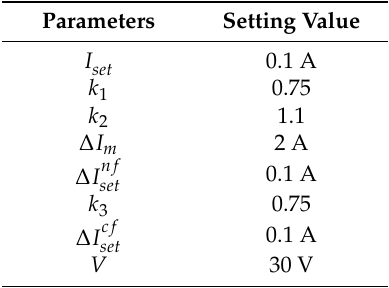
Table 4. Parameters of the fault identification method in the platform.